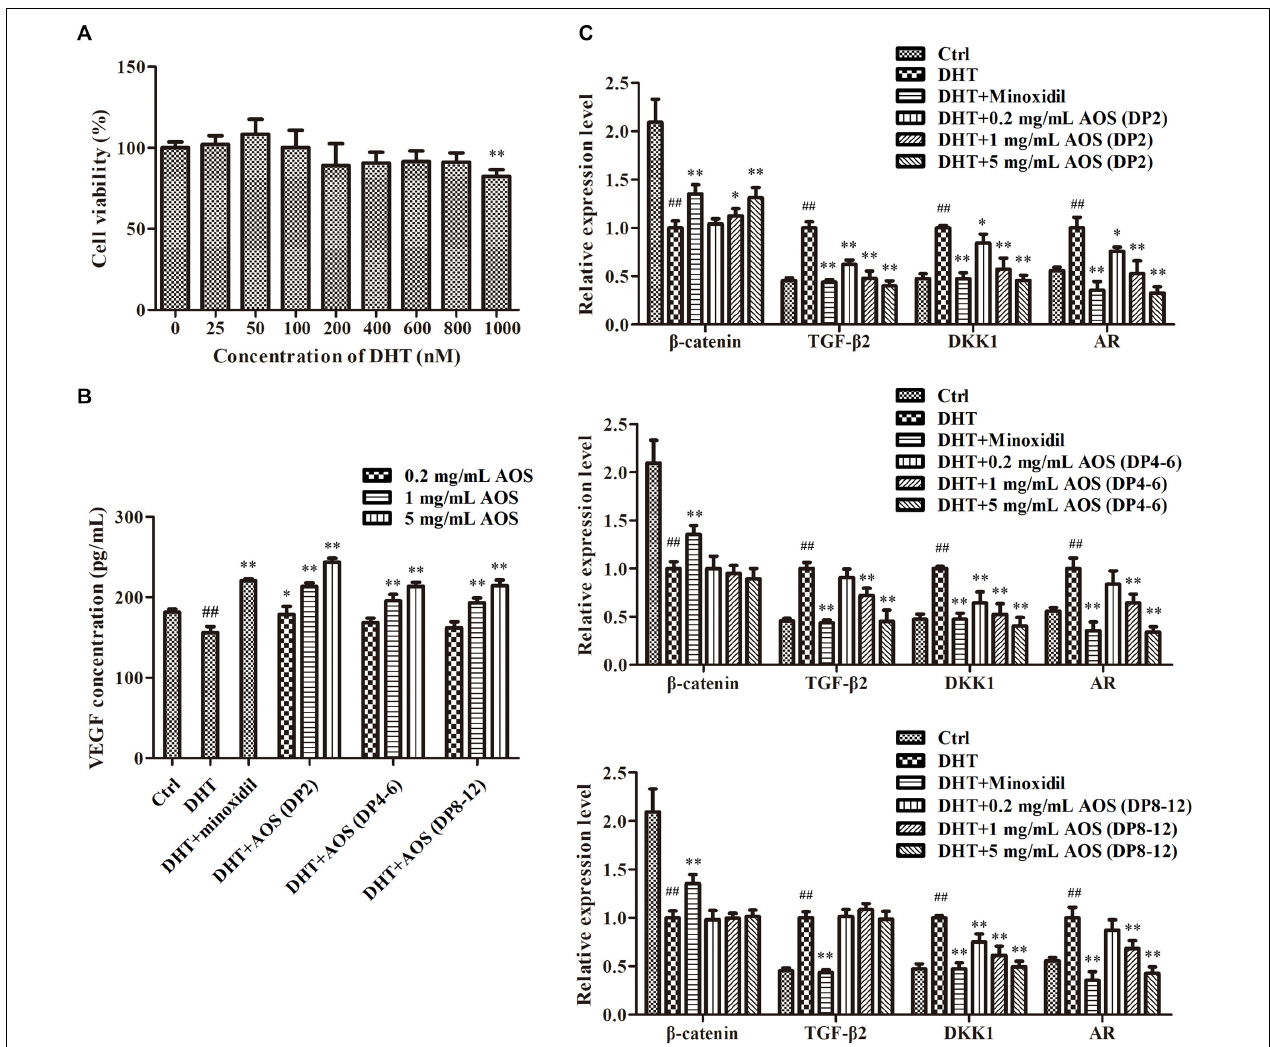
FIGURE 3 | Effects of algal oligosaccharide (AOS) with varying degrees of polymerization (DPs) on vascular endothelial growth factor (VEGF) secretion and hair-growth-related gene expression. (A) Influences of dihydrotestosterone (DHT) treatment on the growth of human hair follicle dermal papilla cells (hHFDPCs). Different concentrations of DHT were added into hHFDPCs. After 24 h, cell viability was determined by 3-(4,5-dimethylthiazol-2-yl)-2,5-diphenyltetrazolium bromide assay. (B) Effects of AOS with varying DPs on the VEGF secretion of hHFDPCs. Different concentrations of AOS were added into hHFDPCs, and the concentration of extracellular VEGF was determined by enzyme-linked immunosorbent assay. (C) Effects of AOS with varying DPs on hair-growth-related gene expression. GAPDH was used as the reference gene for internal control. For all figures, the control group was treated with culture medium. The final concentrations of DHT and minoxidil were 800 nM and 500 µ M, respectively. Columns represent the mean of triplicate assays. Significant differences between DHT and control groups are indicated with double hash symbols ( ## p < 0.01). Results that are significantly different from those in the DHT group are shown by asterisks ( ∗ p < 0.05, ∗∗ p <